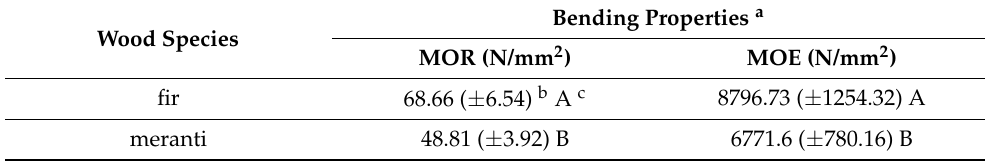
Table 2. Bending properties of fir and meranti wood. Wood